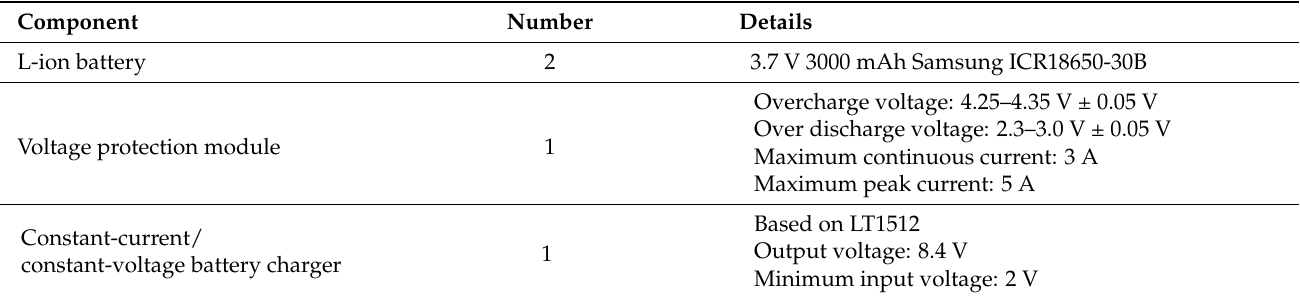
Table 4. Components used in the battery charging circuit.